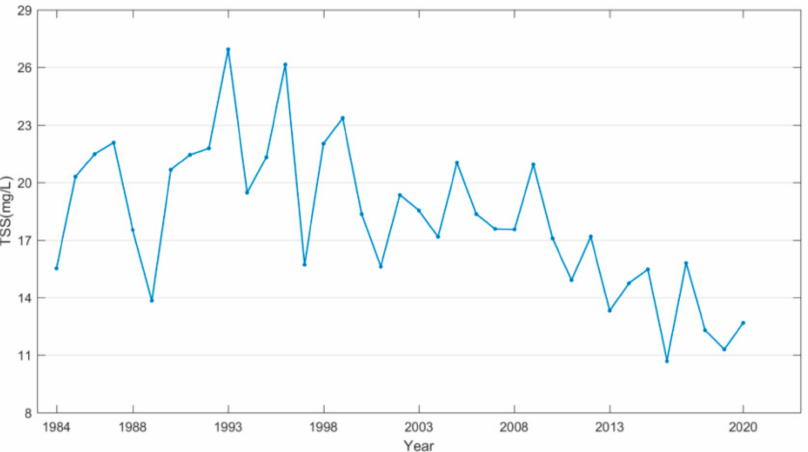
Figure 3. Variation of the annual average TSS in JZB from 1984 to